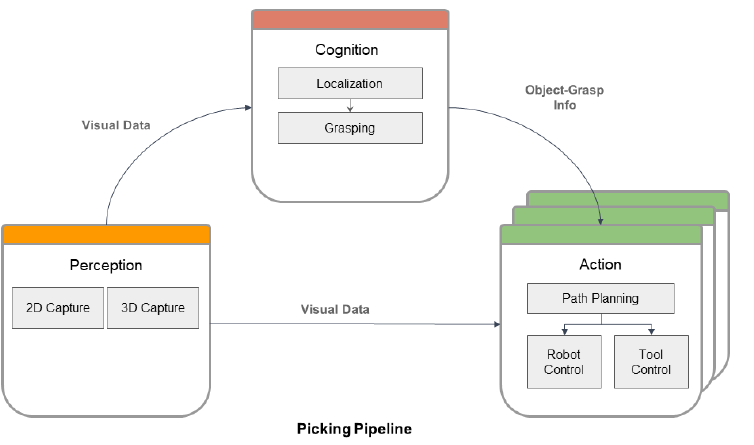
Figure 1. The three main steps in a picking pipeline of PickingDK and the related service